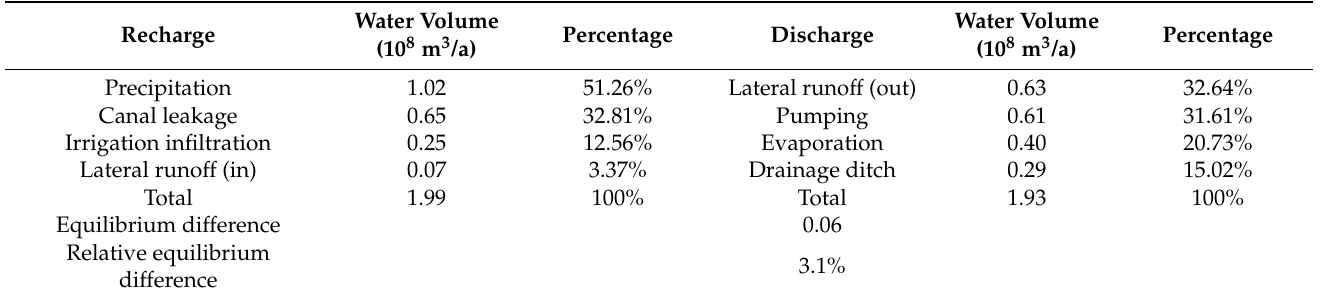
Table 1. Groundwater balance calculation results of MODFLOW